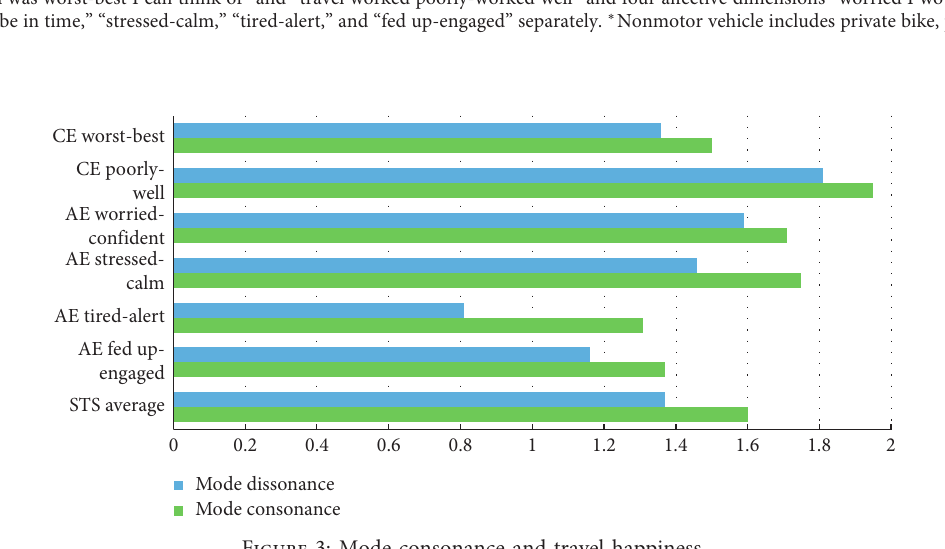
Figure 3: Mode consonance and travel